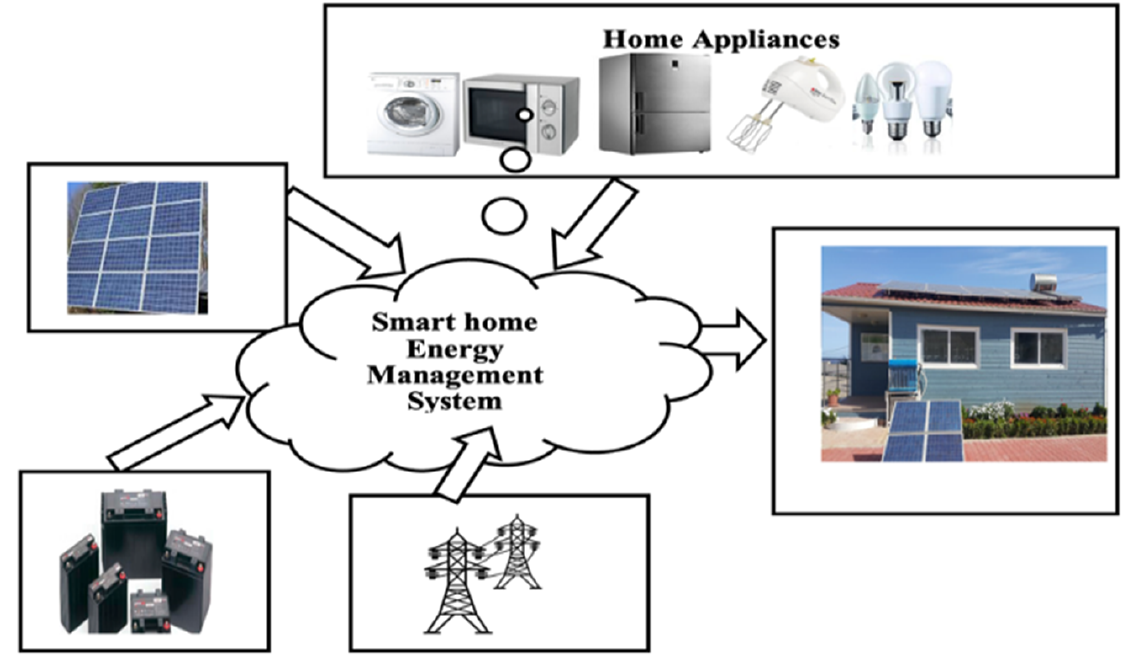
Figure 13. Description of the PV-grid system with backup installed in UDES’ solar house.